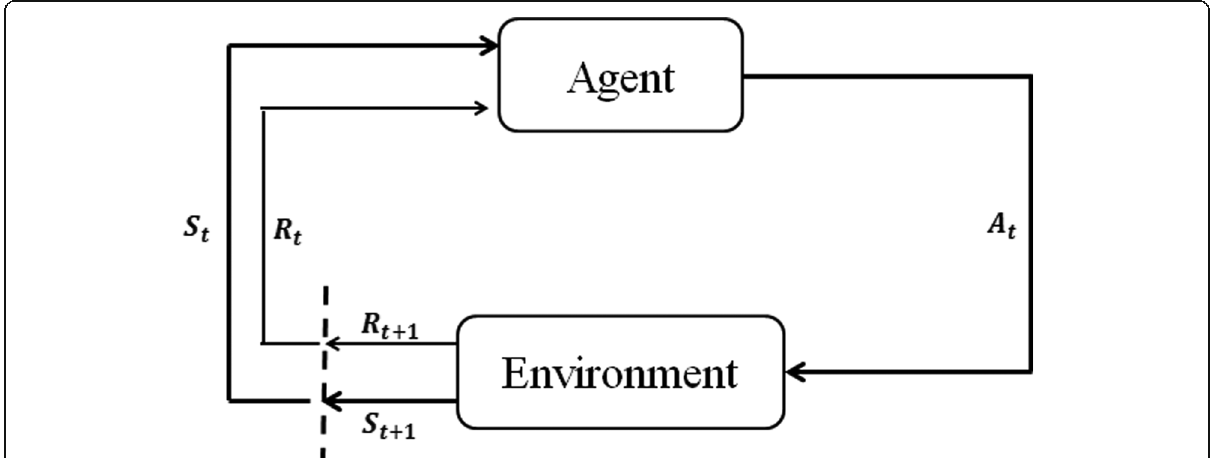
Fig. 4 Shows the interaction process between “ Agent ” and “ Environment, ” “ Agent ” is a learner, “ Environment ” is the learner ’ s environment, A t , S t , and R t represent current action, current state, and current reward, respectively, S t +1 and R t +1 represent the action of the next moment and the state of the next moment, the dotted line in the graph represents the time